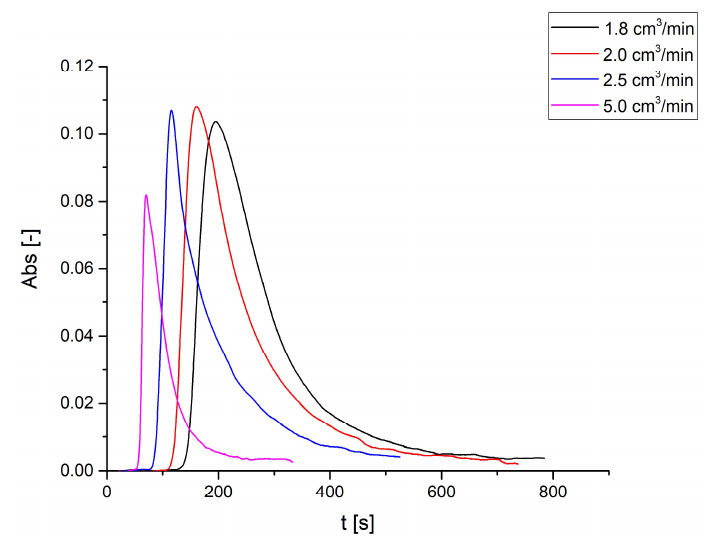
Figure 7. UV spectra of LA 6 M injections at 323 K and different flow rates.